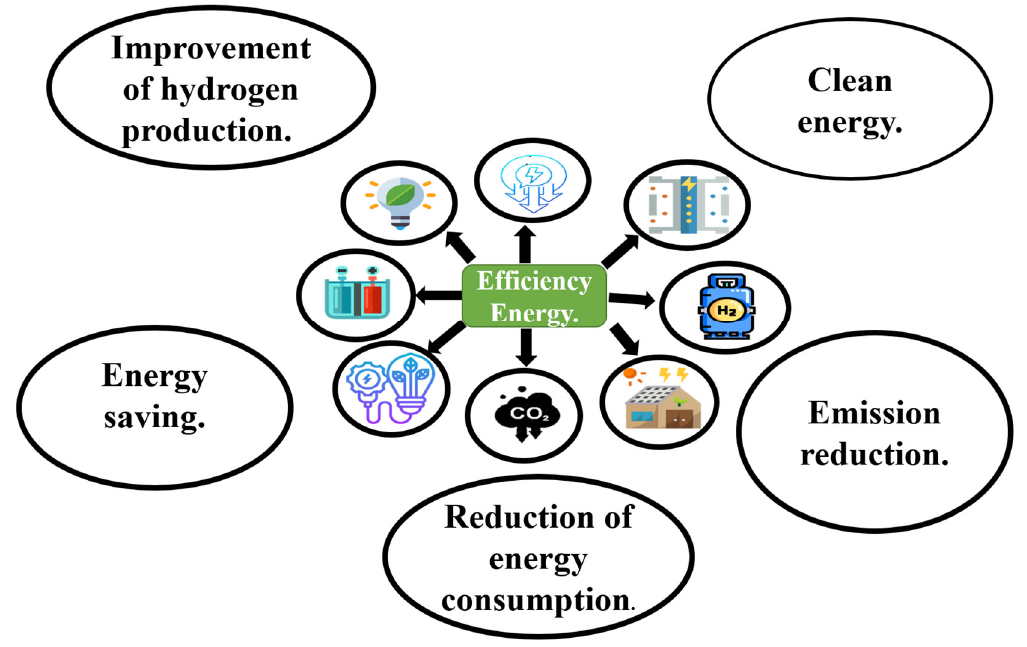
Figure 13. Efficiency energy.